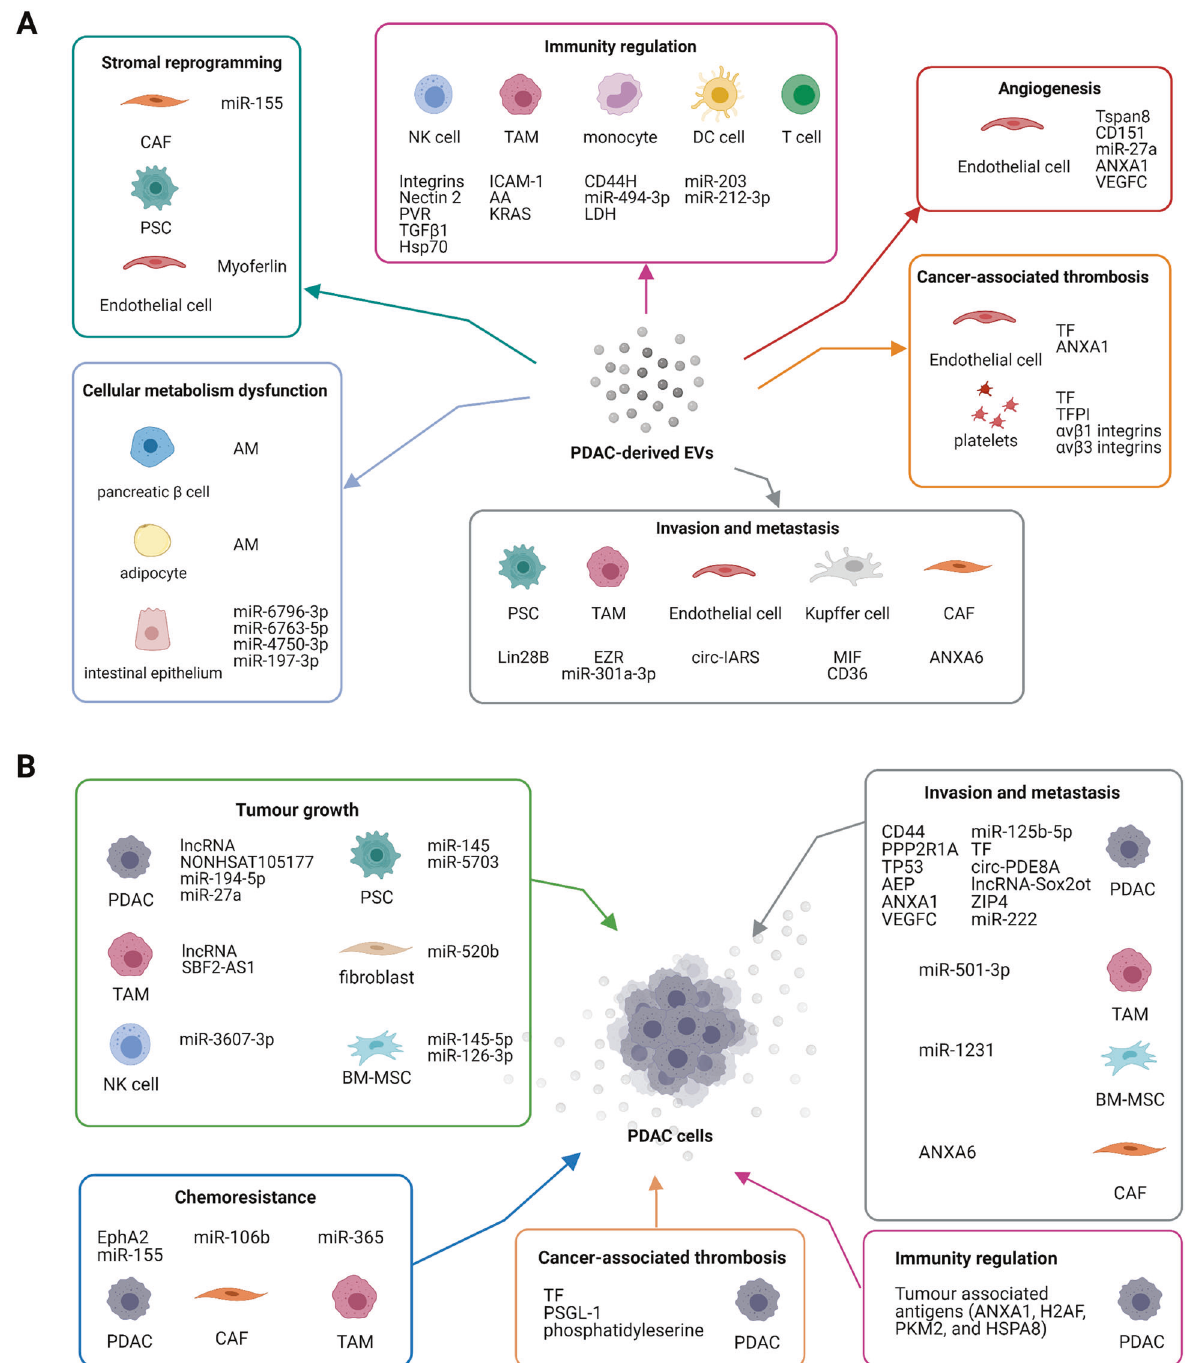
Fig. 1 The EV-mediated communication between PDAC and tumour microenvironment. A PDAC-derived EVs contain various cargos that selectively modulate the surrounding cells types. B Different cell types exist in PDAC microenvironment and produce EVs with various contents that regulate PDAC progression. PDAC pancreatic ductal adenocarcinoma, PSC pancreatic stellate cell, TAM tumour-associated macrophage, CAF cancer-associated fi broblast, BM-MSC bone marrow-derived mesenchymal stem cell, NK natural killer cell, DC dendritic